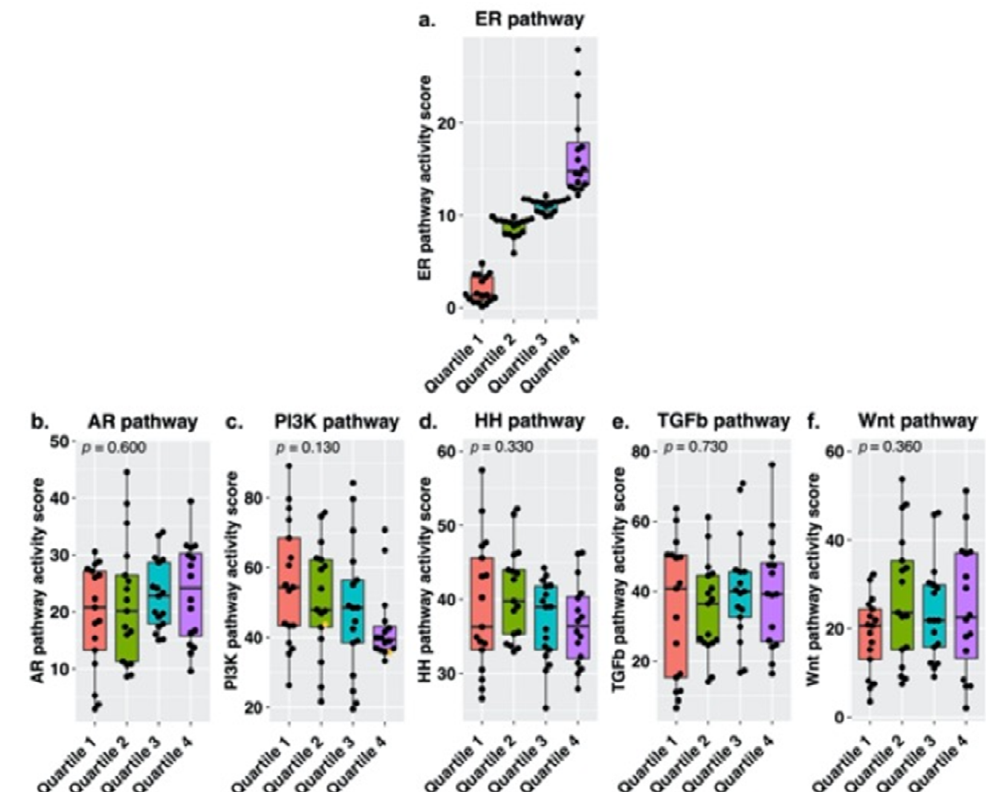
Figure 4. Signal transduction pathway activity measured in high-grade serous carcinoma samples of postmenopausal patients, for the ( a ) estrogen receptor (ER), ( b ) androgen receptor (AR), ( c ) phosphoinositide-3-kinase (PI3K), ( d ) Hedgehog (HH), ( e ) transforming growth factor beta (TGF- β ) and ( f ) canonical wingless-type MMTV integration site (Wnt) pathway. Subgroups were created by dividing ER pathway activity into quartiles (Q1, Q2 and Q3 n = 17, Q4 n = 16). Median pathway activity was compared among the ER quartiles, p -values were derived using a Kruskal–Wallis test. The samples with high SOD2 levels are marked in